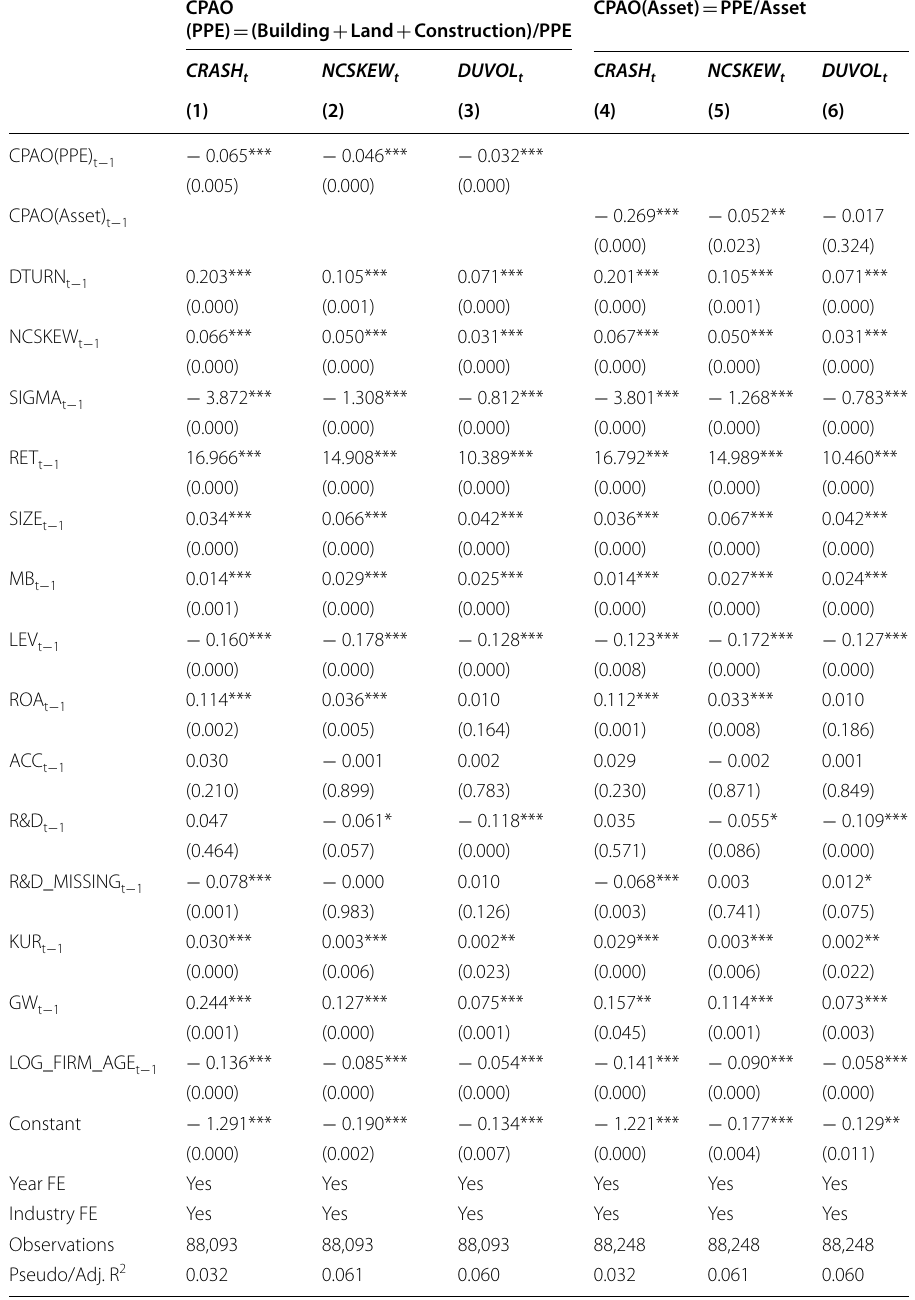
Table 8 Alternative variables of corporate pledgeable asset ownership